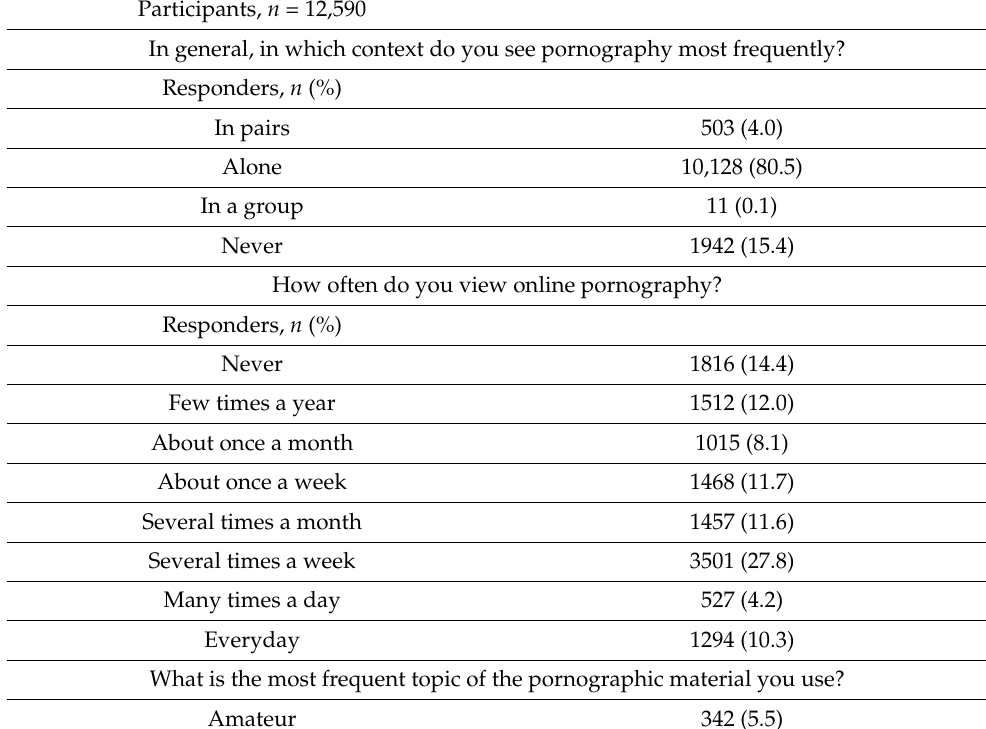
Table 4. Pornography